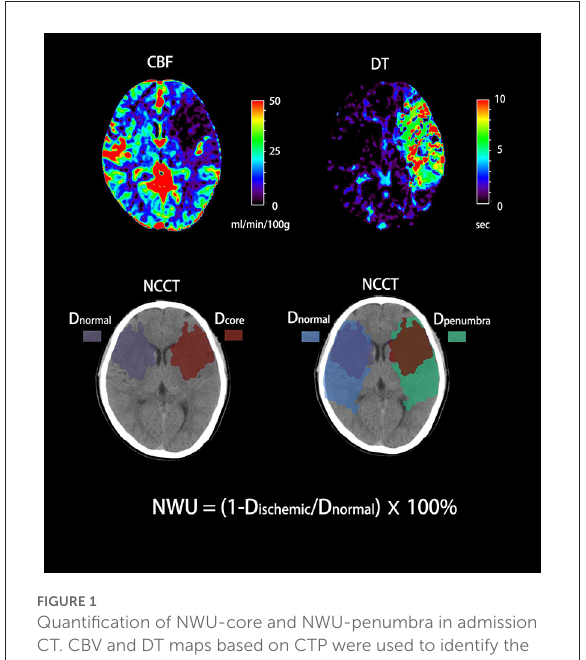
FIGURE1 Quantification of NWU-core and NWU-penumbra in admission CT. CBV and DT maps based on CTP were used to identify the ischemic core and penumbra with the setting of different thresholds. The mean density of the ischemic core, ischemic penumbra, and normal tissue derived from mirrored contralateral were then calculated ( D re , D penra , and D nra